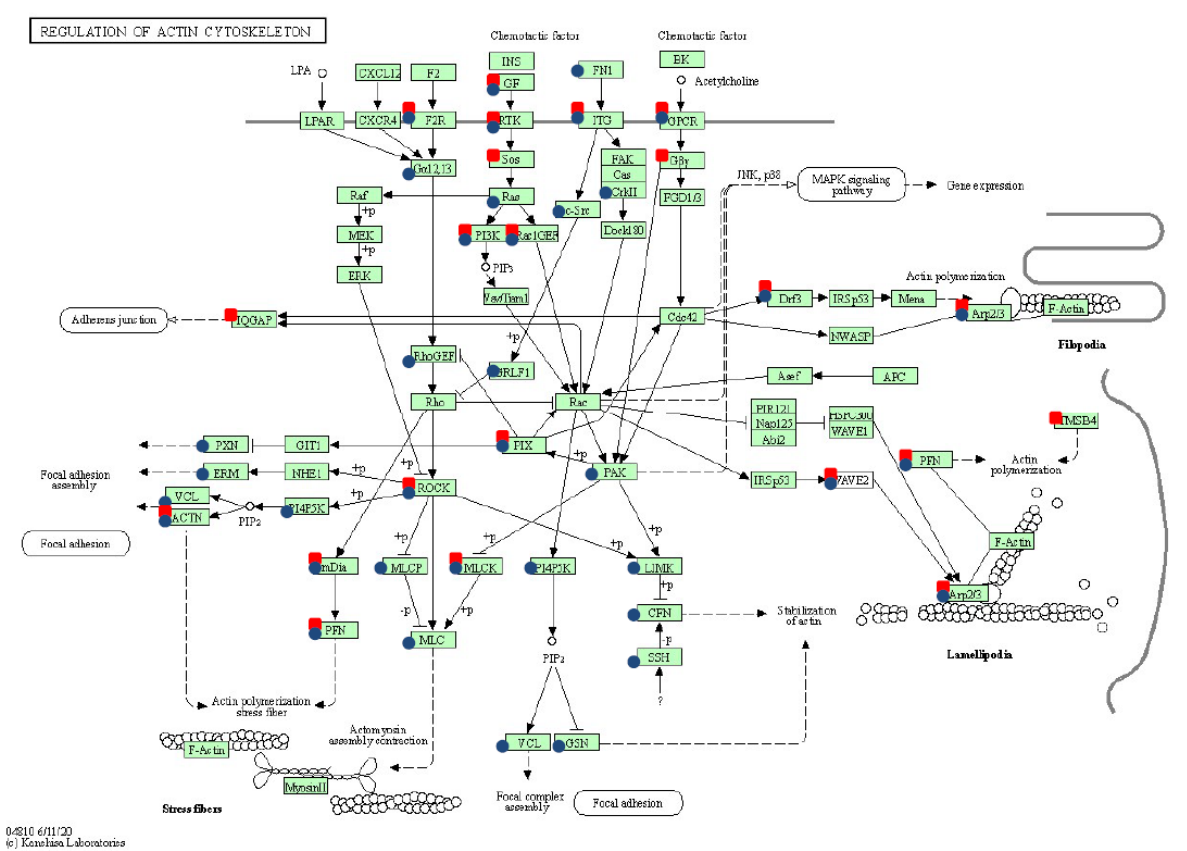
Figure 3. Cell cycle pathway (ecb 04110) over-represented following two strategies of sarcoid- dependent neoplastic transformation triggered by either BPV-E4 or BPV-E1^E4 transgenes. The red squares denote genes modified by BPV-E4 insert, while the blue circles indicate BPV-E1^E4 transgene-induced modifications; arrows present molecular interaction or relation, while dotted arrows show indirect link or unknown reaction.